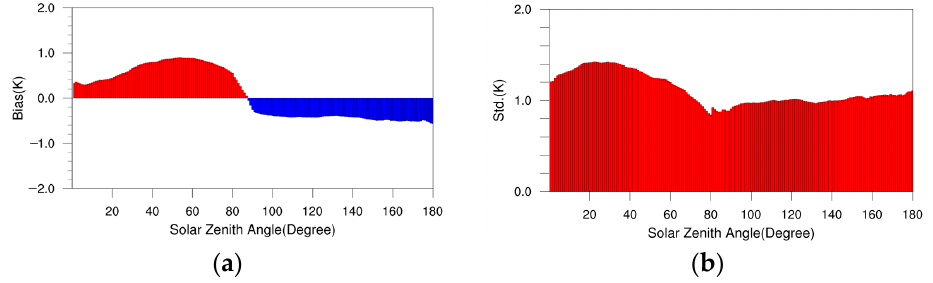
Figure 8. ( a ) Biases and ( b ) standard deviations of Fengyun-4B/AGRI channel 8 brightness temperature observations and RTTOV simulations with respect to solar zenith angles calculated at 1° intervals over the ocean under clear-sky conditions and with satellite zenith angles less than 60° from June to November 2022.